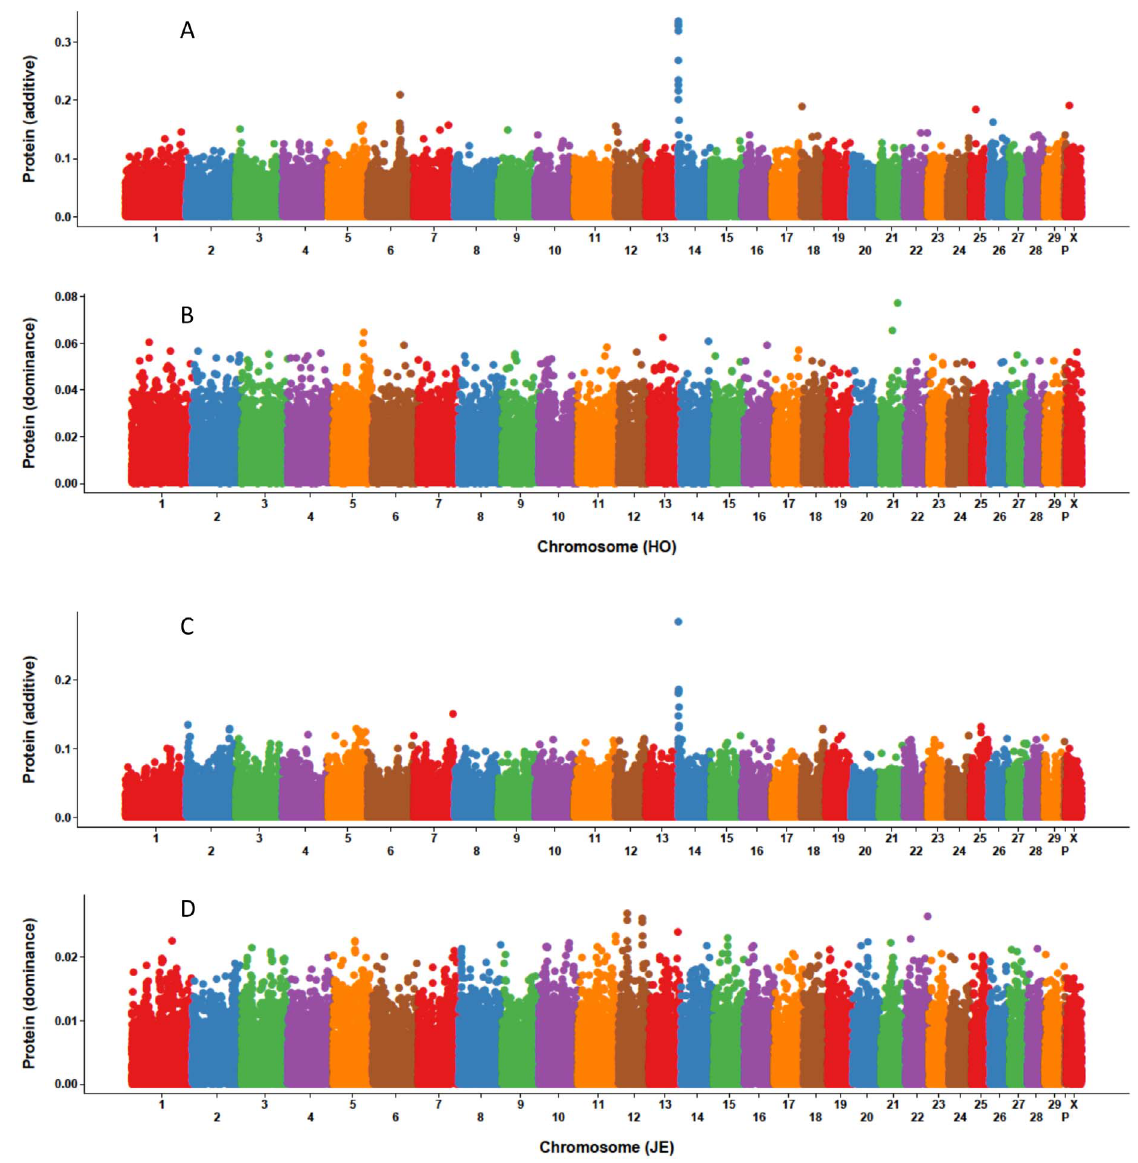
Figure 3. Size and location of marker additive and dominance effects for protein yield of Holsteins and Jerseys. Holstein additive (A) and dominance (B) effects and Jersey additive (C) and dominance (D) effects were estimated with a model that included additive and dominance (values) effects.